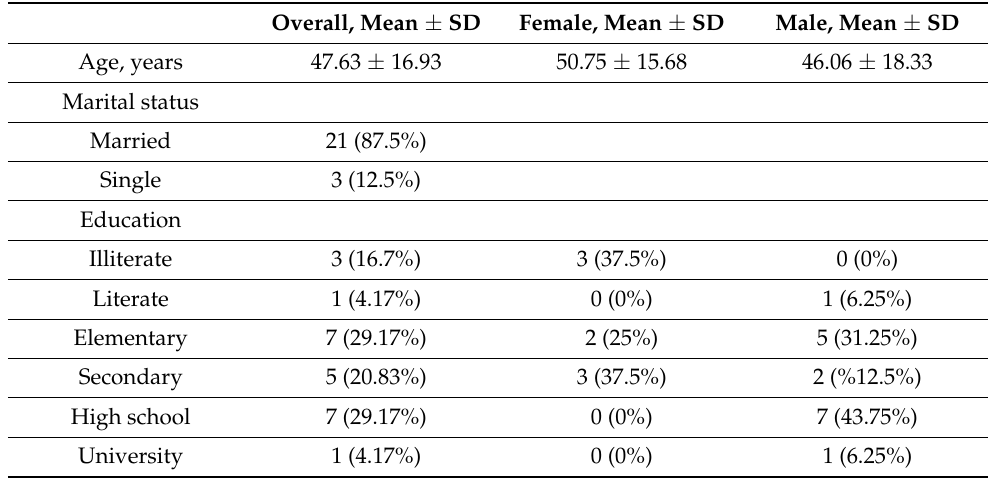
Table 1. The demographic characteristics of